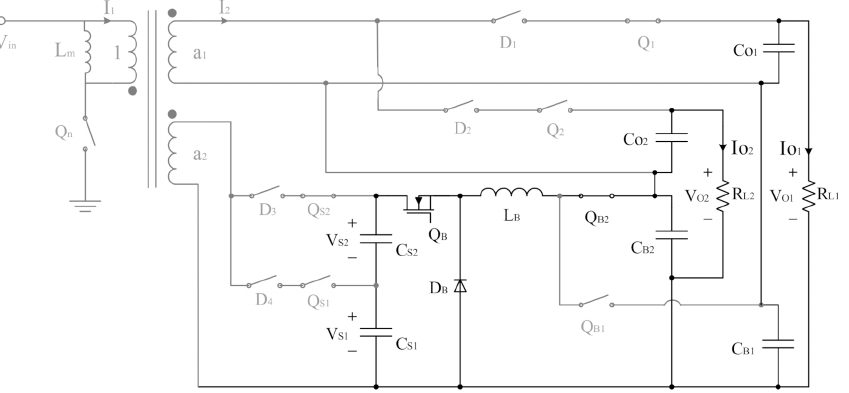
Figure 8. Equivalent circuits of the proposed SIMO converter within